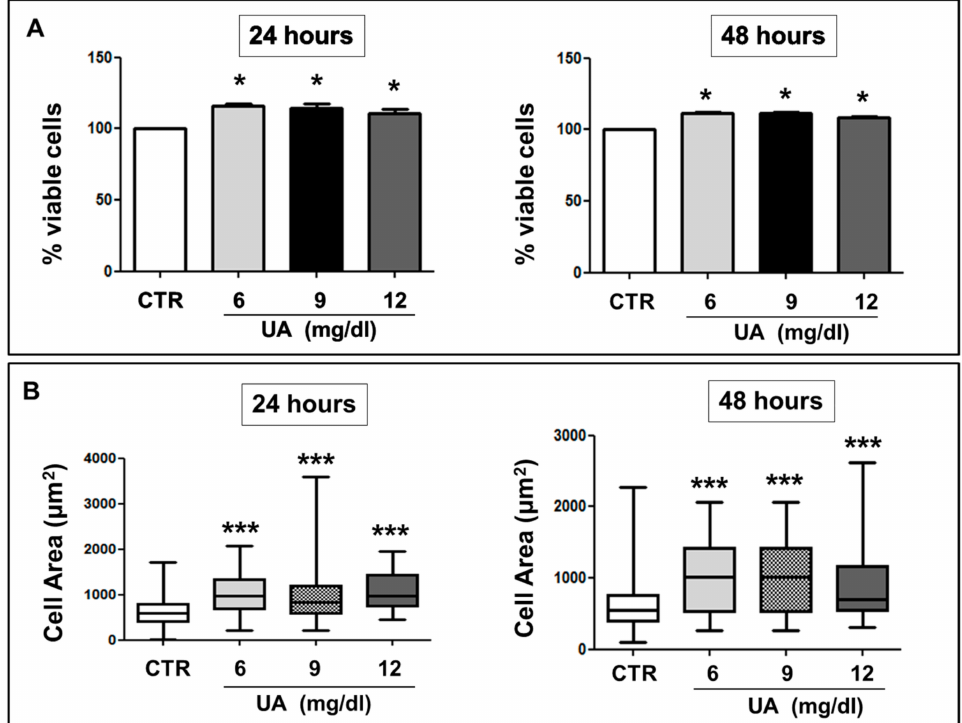
Figure 1. UA effects on cell viability and MOVAS cells area. ( A ) Incubation of VSMCs with UA for 24 and 48 h stimulated proliferation at concentrations of 6, 9 and 12 mg/dL and ( B ) a sig- nificant increase in VSMC area, regardless of UA concentration and time exposition. All results represent means ± SEM ( A ) and median ± IQR ( B ) obtained from three/four independent exper- iments. * p < 0.05, *** p < 0.0001 vs. CTR. VSMC = Vascular Smooth Muscle Cells; UA = Uric Acid; CTR = controls, no treated cells; IQR = Interquartile Range.